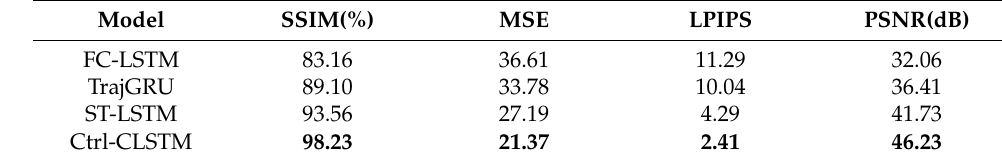
Table 2. Quantitative results on each evaluation metric.